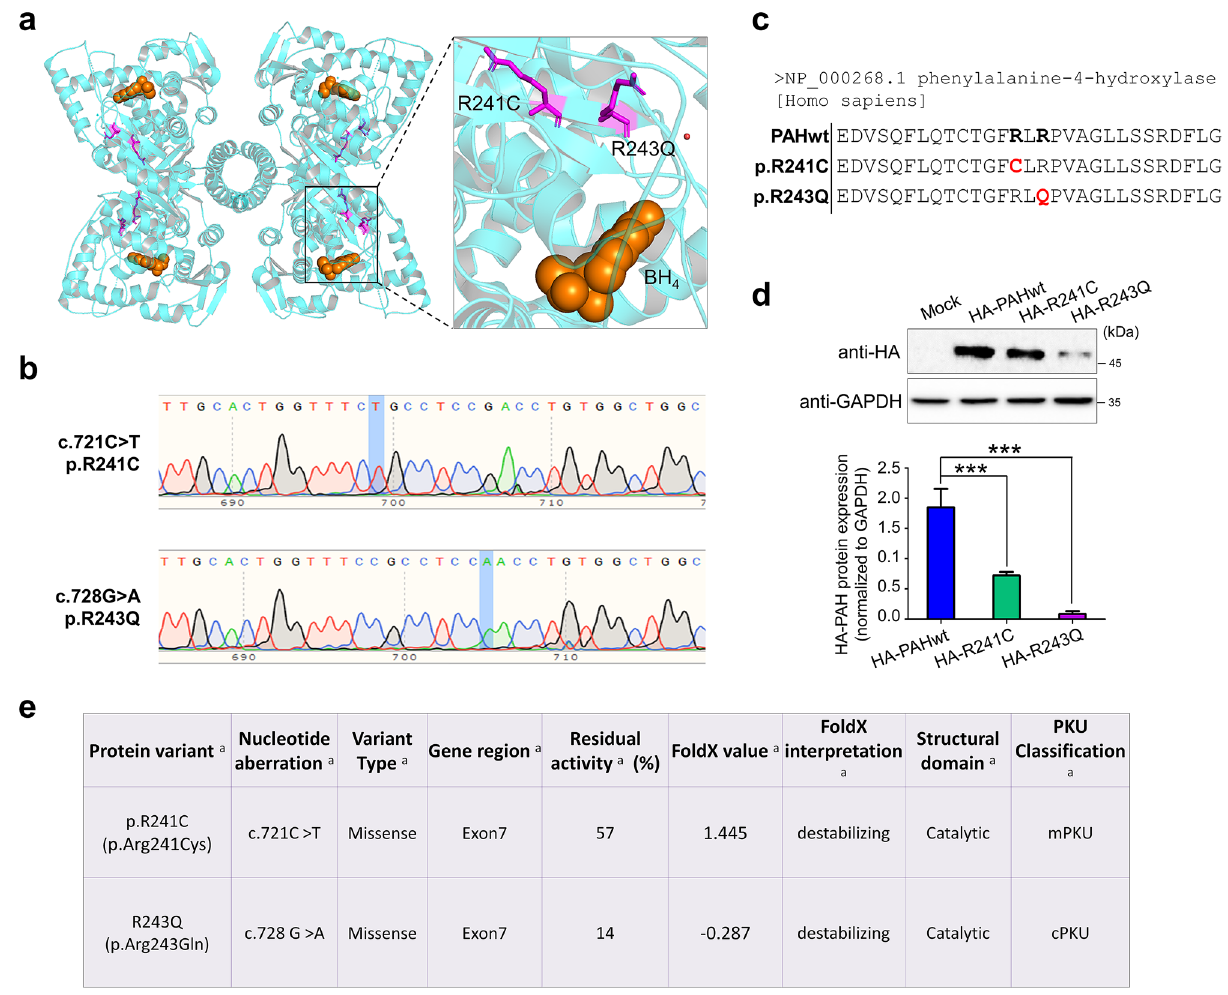
Figure 1. Generation of PAH variants by mutagenesis. ( a ) The crystal structure of the PAH tetramer in an auto-inhibited conformation (PDB code 6HYC) is presented as ribbon (cyan). The location of R241C and R243Q mutations in all four subunits is presented in magenta. BH 4 cofactor is shown as orange spheres in all four subunits indicating the location of active site. An enlarged image of the mutation sites (R241C and R243Q) and cofactor BH 4 in one of the subunits is shown on the right. The figure was generated using the PyMol program. ( b ) Sanger sequencing analysis of PAH_ c.721C>T (R241C) and c.728 G>A (R243Q) showing point mutations on the PAH gene. ( c ) The amino acid substitutions for R241C and R243Q are represented. NCBI Reference Sequence: NP_000268.1. The red font denotes the amino acid change from arginine (R) to cysteine (C) in p.R241C and glutamic acid (Q) in p.R243Q variant. ( d ) Western blot analysis of PAHwt, R241C and R243Q variants. Band intensity was estimated using ImageJ software, normalized to GAPDH, and